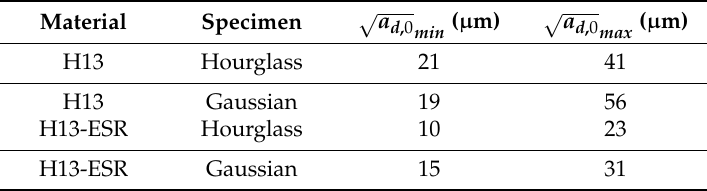
Table 3. Inclusions originating failures: Smallest and largest values.